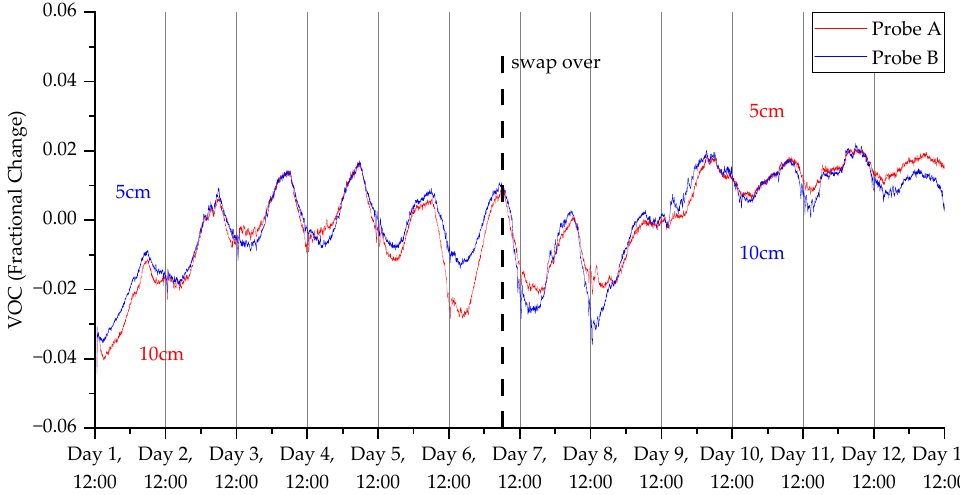
Figure 16. VOC measurements for the second deployment in Wellesbourne campus woodland. Data collection commenced on 12 July 2022 at 12:45 (24 h time).